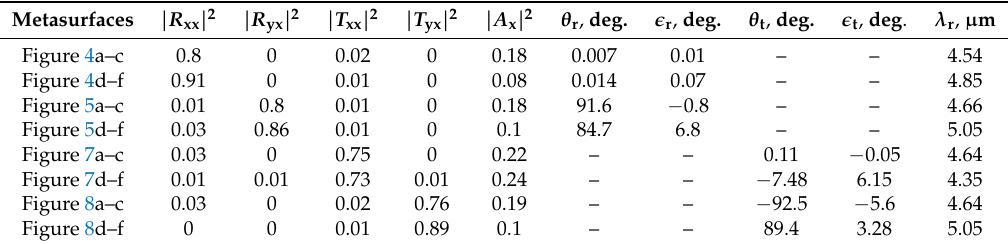
Figure 8. ( a ) The unit cell of a metasurface designed for the cross-polarized transmission regime. The unit cell consists of horizontally-oriented helices with the lattice period of p h = 1.8 µ m. ( b ) Simulated polarized reflectance, transmittance, and absorbance spectra at normal incidence with depicted top view of the unit cell in the inset. ( c ) The rotation and ellipticity wavelength dependence of the metasurface. ( d ) The unit cell of a metasurface based on vertically-oriented helices with a lattice period of p v = 1.2 µ m for cross-polarized transmittance. ( e ) Co- and cross-polarized reflectance, transmittance, and absorbance spectra with the top view of the unit cell in the inset. ( f ) The rotation and ellipticity wavelength dependence of the metasurface. Table 1. Numerically calculated characteristics of the